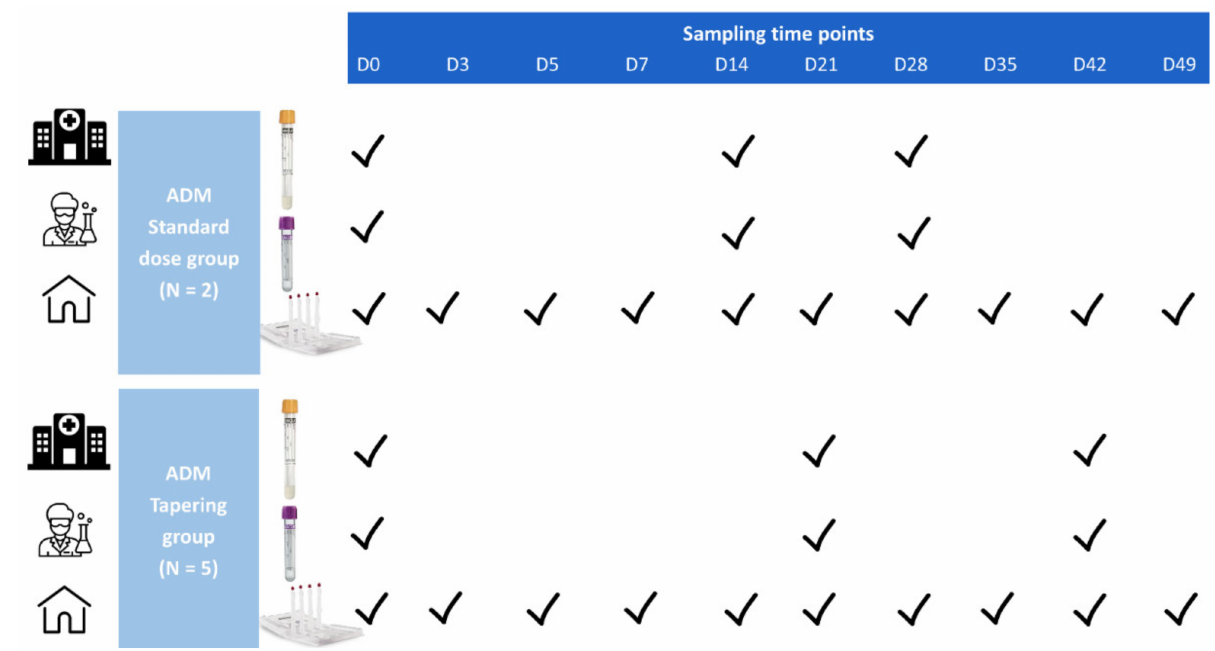
Figure 2. Overview of sampling time points in the substudy of the SUPRA-A trial. Patients were asked to self-sample at 10 predefined time points (day 0 (after training and under supervision of nurse), 3, 5, 7, 14, 21, 28, 35, 42, and 49) using a VAMS device, marketed as Mitra ® (Neoteryx LLC, Torrance, CA, USA). At day 0, day 14 and day 28 or day 0, day 21 and day 42 whole blood and serum were collected simultaneously, allowing comparison of the different matrices, i.e., capillary